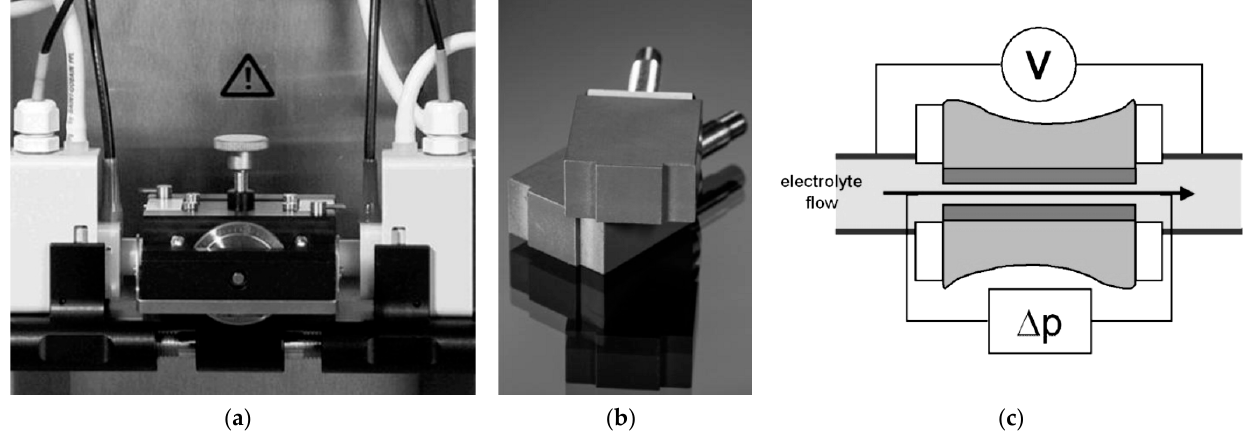
Figure 1. Adjustable Gap Cell mounted between electrodes ( a ); Sample holder (10 × 10 mm, center) ( b ); Measuring principle ( c ). Scheme of the rectangular slit channel between adjacent solid samples with a planar surface indicating its dimensions is presented in Figure 2. L, W and H stand for the length, width and height of the flow channel, respectively. The blue arrows indicate the direction of electrolyte flow during the ζ measurement.